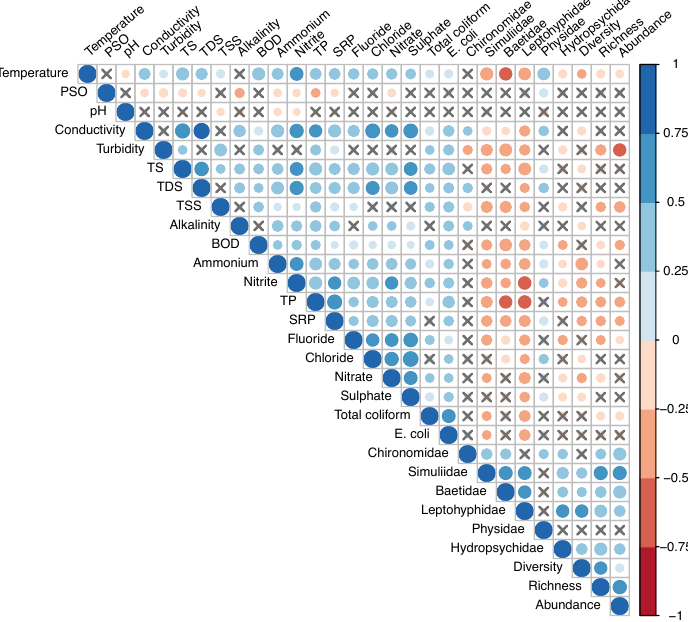
Figure 2. Kendall’s Tau correlation diagram of the water quality parameters in the Virilla river. (Crosses indicate no statistical significance, p >